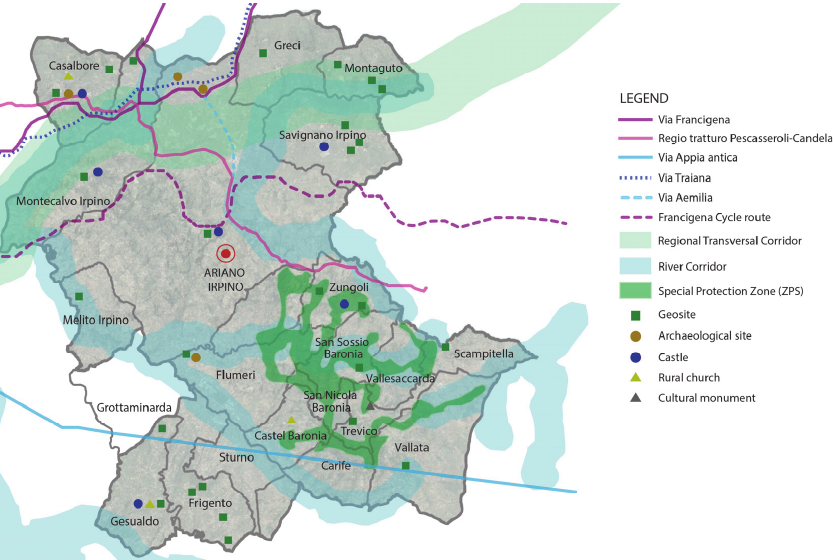
Figure 7. Main cultural and landscape heritage of the Ufita focus area © RI.P.R.O.VA.RE Project (DICIV research unit).